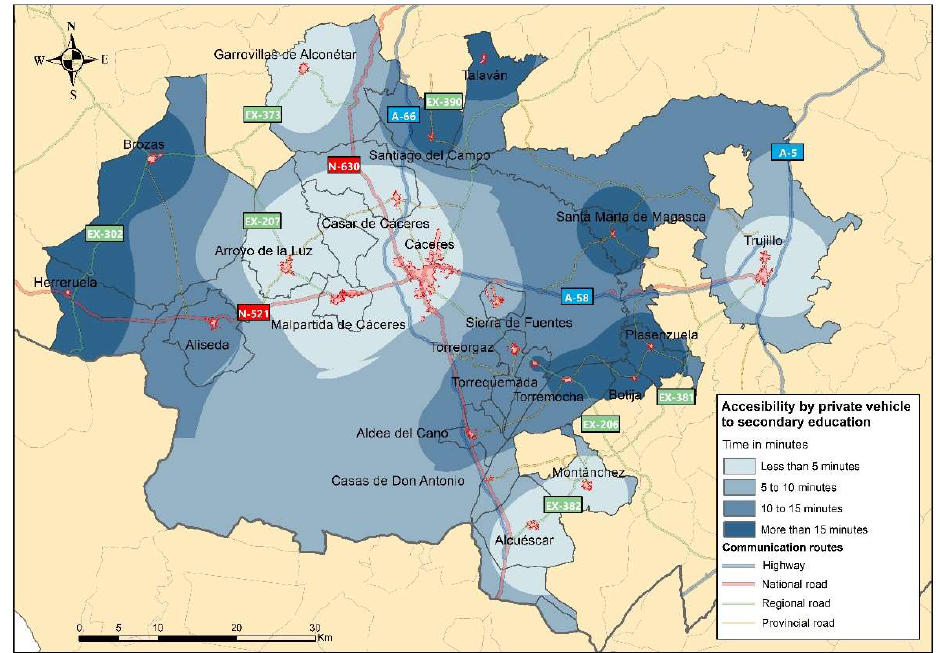
Figure 6. Territorial accessibility to secondary